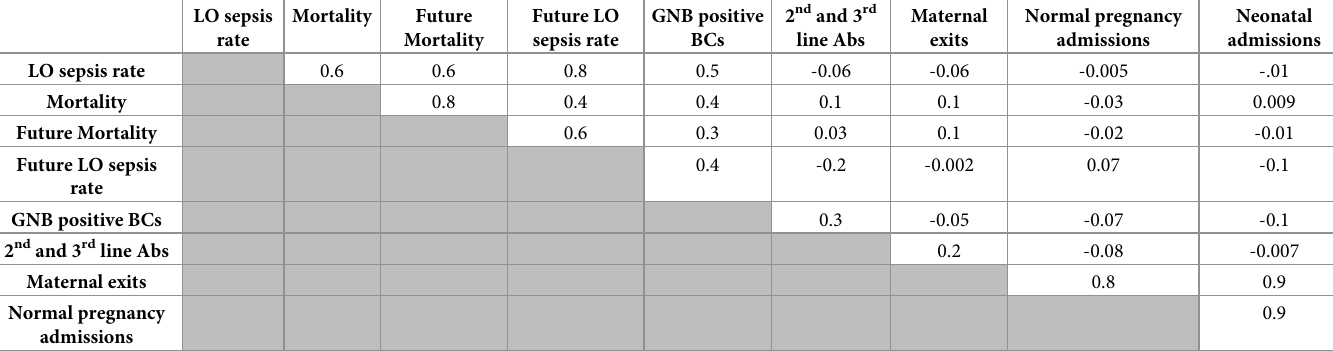
Table 2. Correlation matrix displaying the Pearson correlation coefficient between different outbreak indicators.